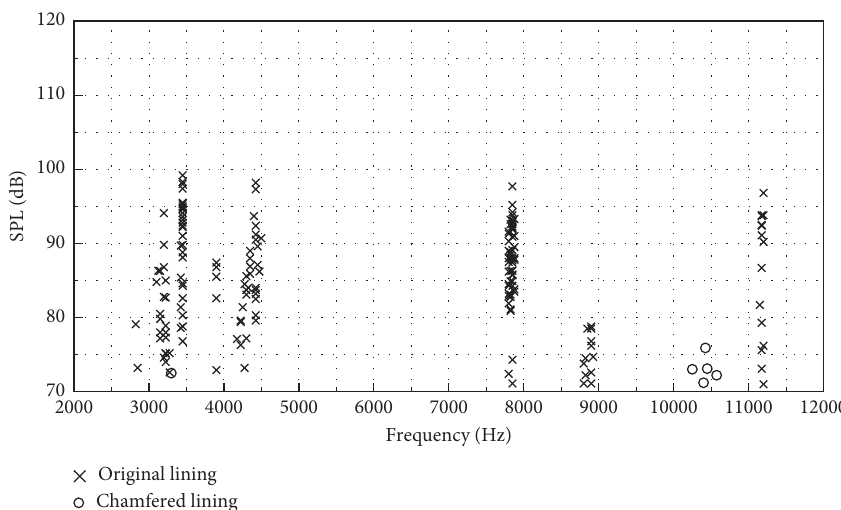
Figure 12: Brake-noise distribution of the original and chamfered brake